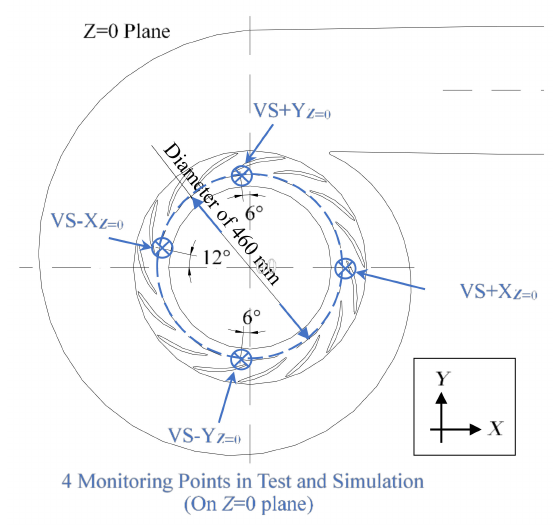
Figure 7. Four monitors points of GCI. Table 3. Evaluation results of discretization error.